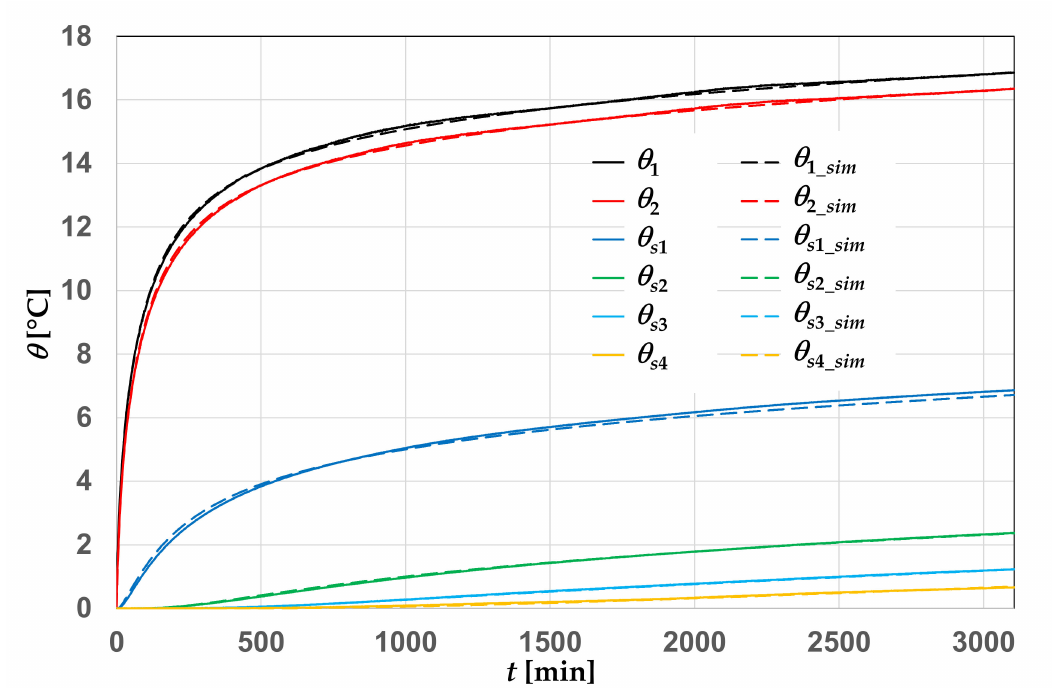
Figure 12. Experimental time evolutions of θ 1 , θ 2 , θ s 1 , θ s 2 , θ s 3 , θ s 4 and simulated ones, denoted by the subscript sim , for